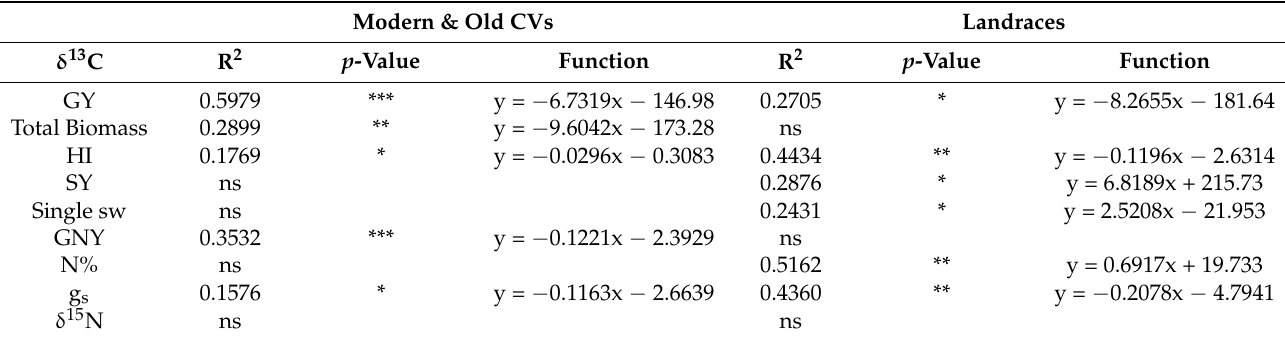
Table 4. Regression analysis for grain δ 13 C (‰) with the assayed yield parameters and gs: GY, grain yield (g pot − 1 ); Total Biomass (straw yield plus ear and grain, g pot − 1 ); HI, Harvest Index; SY, straw yield (g pot − 1 ); Single sw, single seed weight (mg); GNY, grain N yield (g N pot − 1 ); N%, N concentration (% DW); g s , stomatal conductance (mmol H 2 O m − 2 s − 1 );